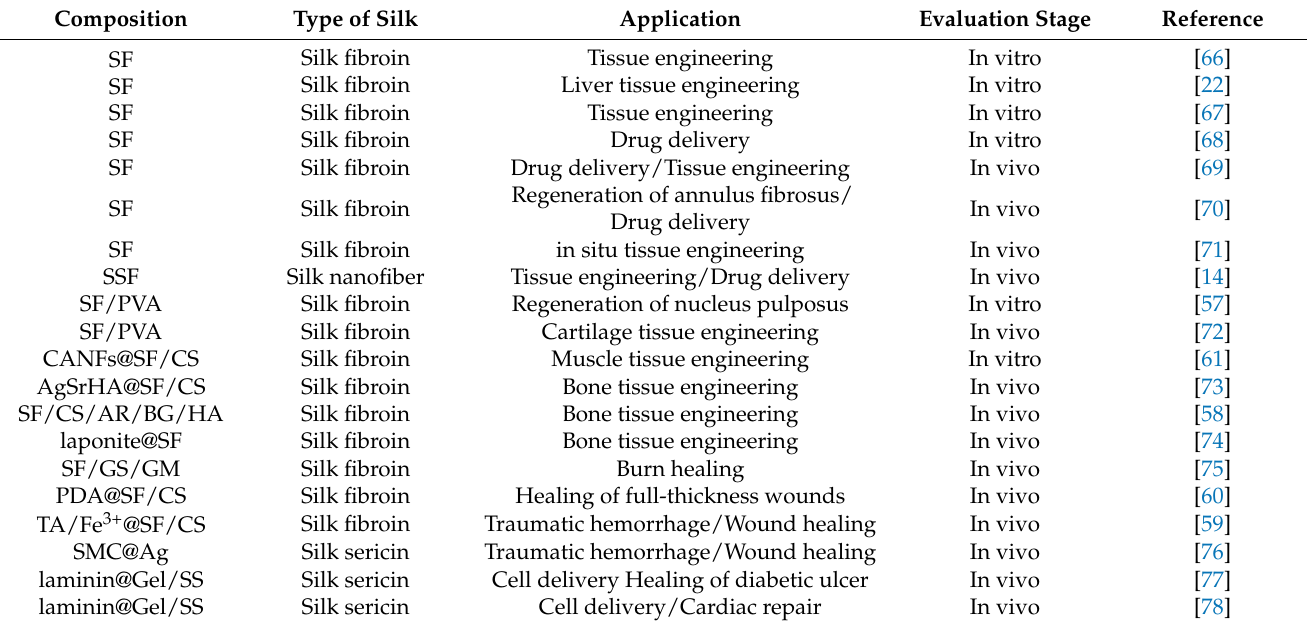
Table 1. Biomedical applications of silk-based